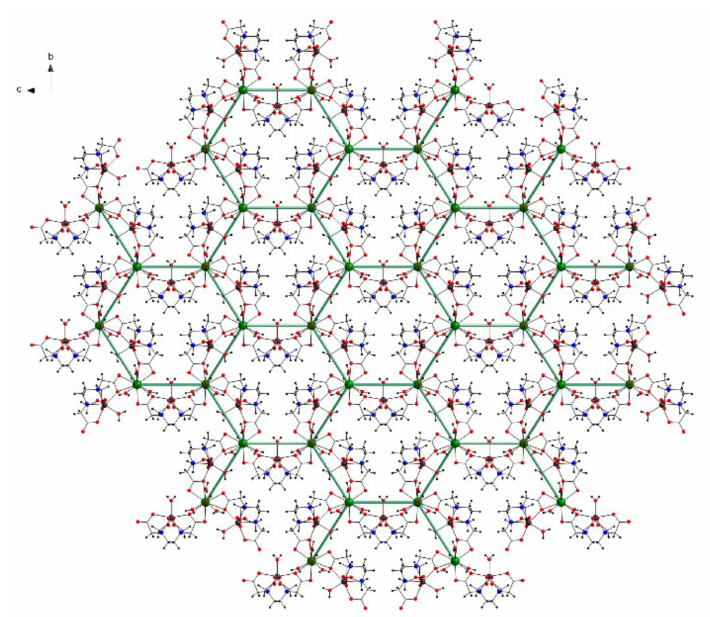
Figure 5. View of the two-dimensional layer with a honeycomb like structure along the a axis in 1 (free water molecules omitted for clarity).